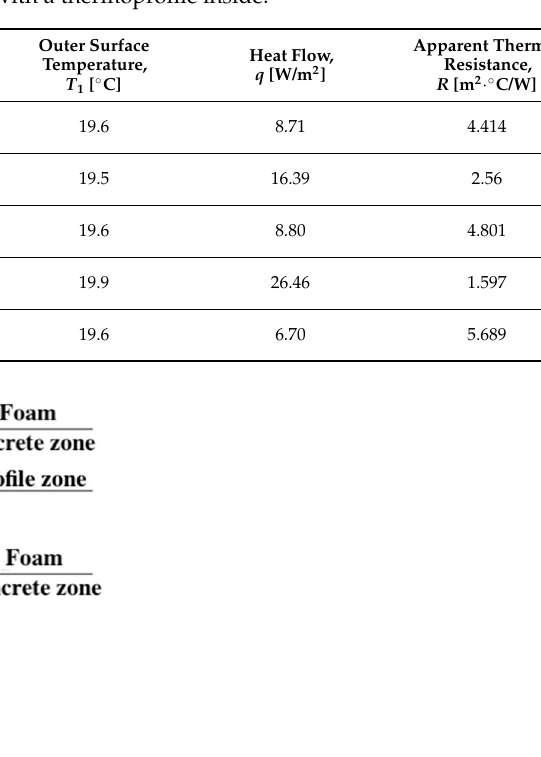
Figure 7. Separation of the working surface into material zones.